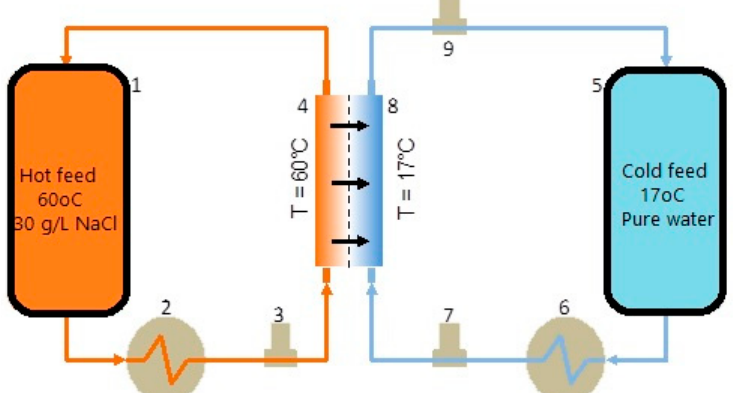
Figure 2. Experimental membrane distillation (MD) set-up of hot feed (30 g / L salt and at 60 ◦ C) and cold feed (pure water and at 17 ◦ C). 1-hot feed water tank, 2-hot feed heat exchanger, 3-mass flow controller of hot stream membrane inflow, 4-membrane side of hot feed, 5-cold feed water tank, 6-cold feed heat exchanger, 7-mass flow controller of cold stream membrane inflow, 8-membrane side of cold feed, 9-mass flow controller of cold stream membrane outflow.